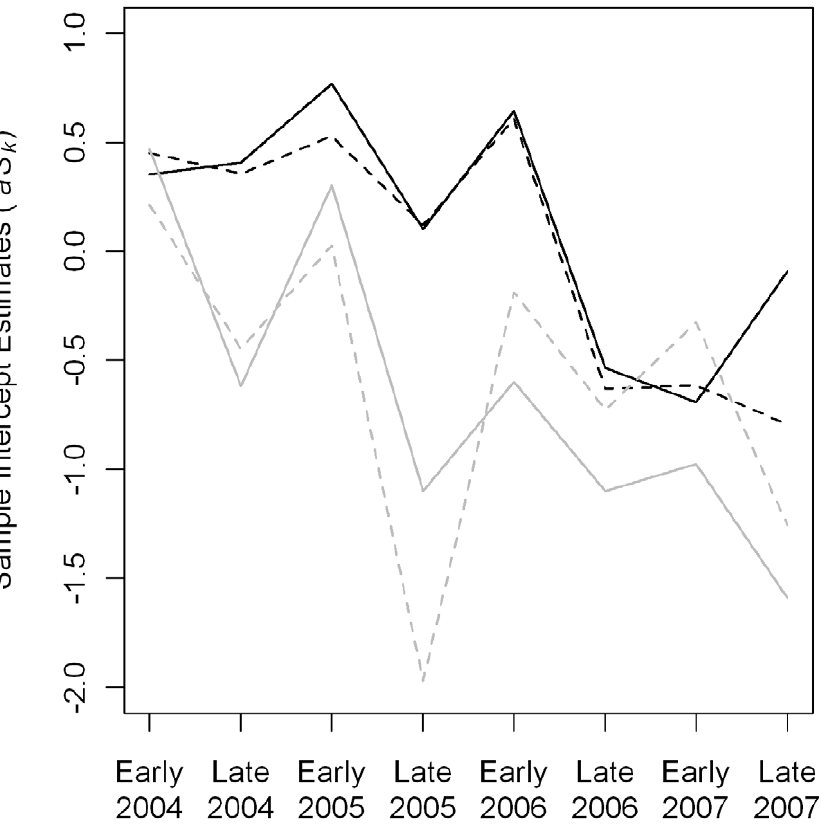
Figure 9. Posterior distribution medians for the logistic regression sample intercepts. The black lines are villages in the Kon Tee sub- district, and the gray lines are villages in the Na Bo Kam sub-district. Solid lines indicate the higher density villages, and dashed lines are the lower density villages.